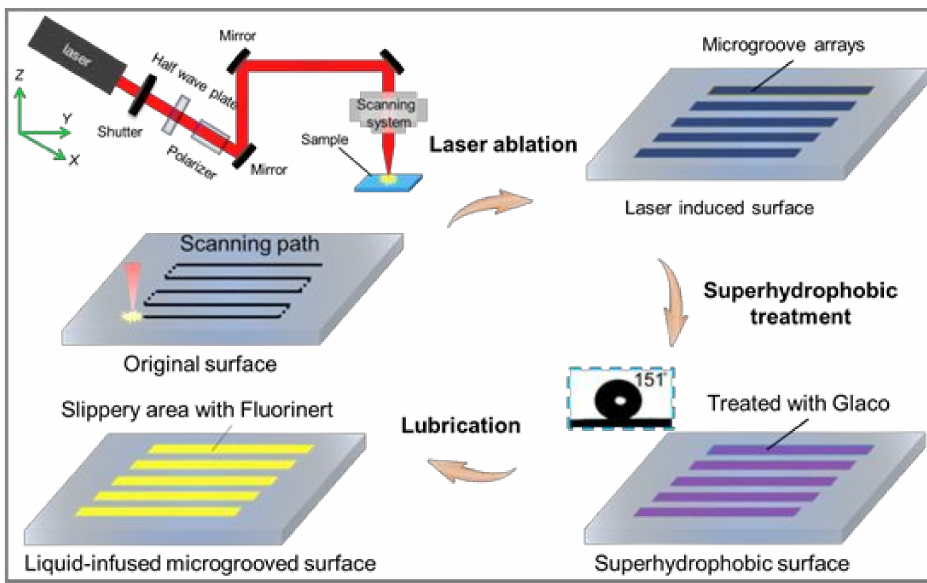
Figure 1. The fabrication process of liquid-infused anisotropic microgrooved slippery surface (LIAMSS), which mainly contains three steps: femtosecond laser ablation, superhydrophobic treat- ment and lubrication process. It should be noted that the superhydrophobic treatment is meant to reduce the surface energy of the LIAMSS such that the lubricant layer could remain stable in